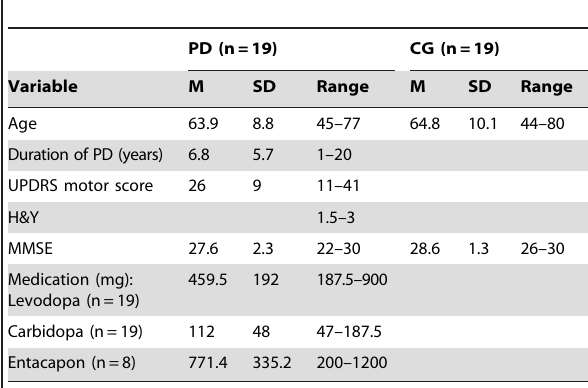
Table 1. Demographic and clinical characteristics of PD